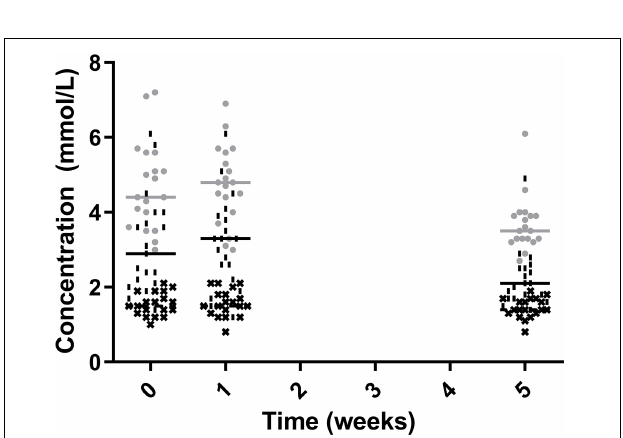
FIGURE 2 | Concentration of circulating haemoglobin l and iron participants who completed the study. The mean of each measurement shown as a solid black line. There were statistical increases for both haemoglobin and iron from week 1 to week 5.